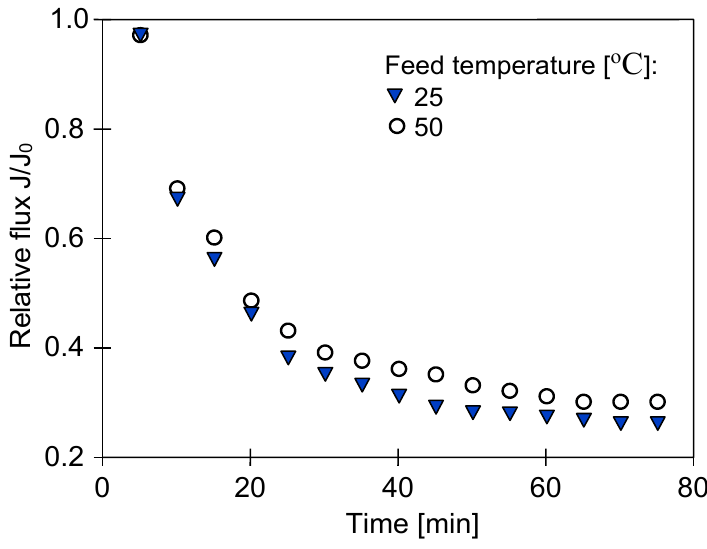
Figure 10. Effect of temperature on the relative permeate flux during MF of model emulsion (C F = 90 mg/L). Module MF1, V F = 0.5 m/s, TMP = 0.05 MPa.